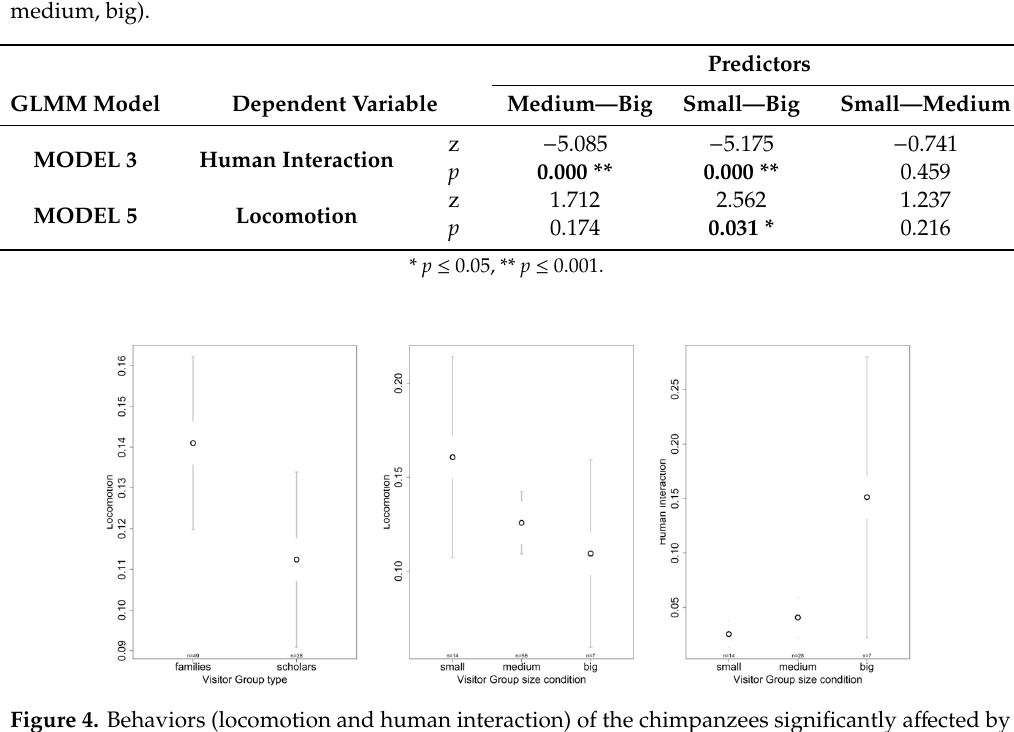
Figure 4. Behaviors (locomotion and human interaction) of the chimpanzees significantly affected by aspects of the visitor groups with a confidence interval of 95%. Table 6. Behavior of the chimpanzees significantly affected by aspects of the visitor groups.